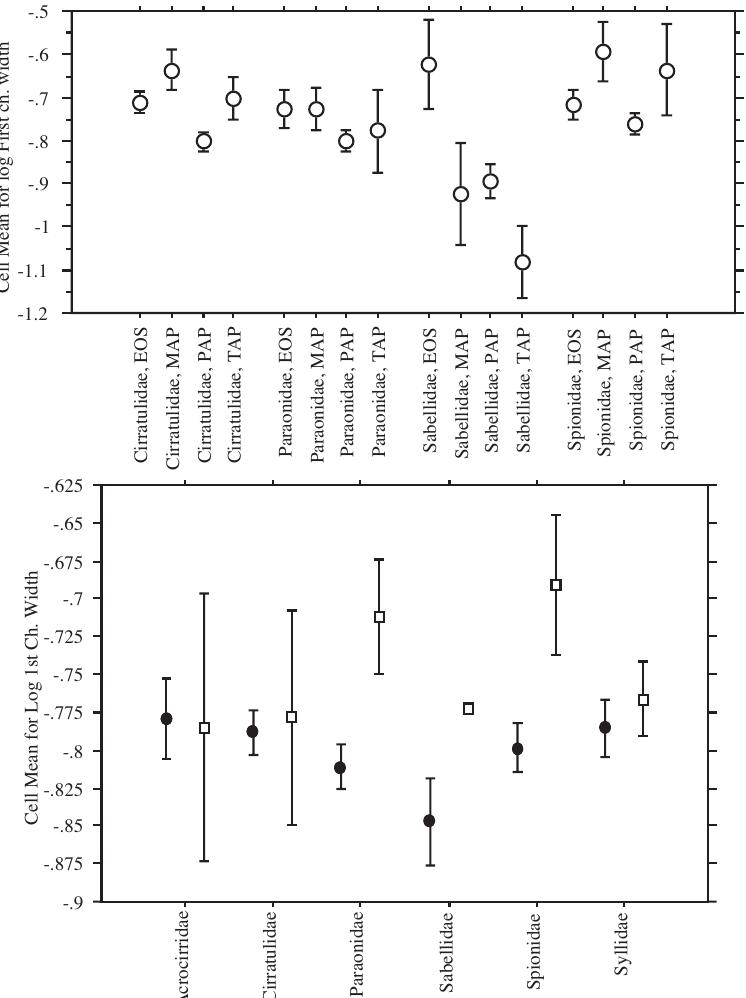
F IG . 6. – Variation in size of different families within the Atlantic (top) and Pacific (lower). Cirratulidae and Spionidae are significantly smaller at PAP than other sites; Sabellidae show considerable between site variation with specimens from PAP, MAP and TAP significantly smaller than EOS; Paraonidae specimens show no significant differences in size between the sites. E – EOS, M – MAP, P – PAP, T – TAP. The lower fig- ure shows the same analyses for the dominant species in the EqPac studies. Samples have been amalgamated into sites with phytodetrital input (filled circles) and non-phytodetrital sites (open circles). Although the Paraonidae appear to show that individuals at the phytodetrital sites are smaller this is not significant (p=0.0503). Only the individuals of Spionidae are significantly smaller in phytodetrital sites